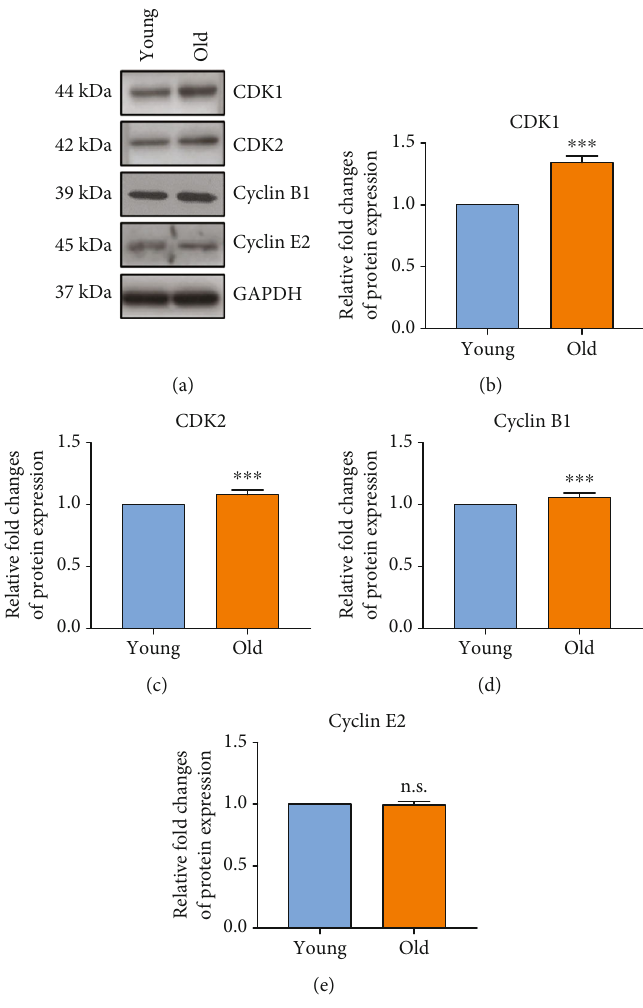
Figure 5: Changes of CDK family protein expression with replicative senescence in TMSCs. (a) Western blot analysis of cell cycle markers which are (b) CDK1, (c) CDK2, (d) cyclin B1, and (e) cyclin E2. The bar graph represents relative fold changes in gene expression, normalized by respective GAPDH. The p values were considered statistically signi fi cant ( ∗∗∗ p < 0 : 001 , ∗ p < 0 : 05 ; n.s.: not signi fi